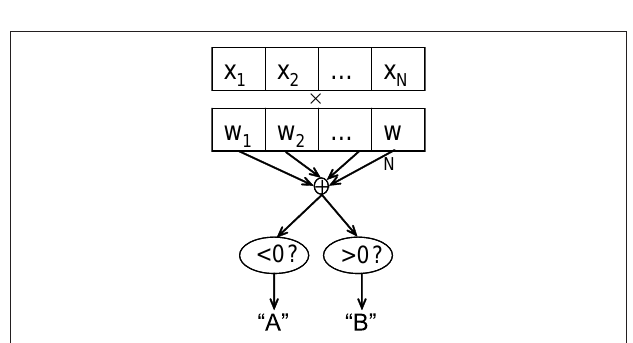
FIGURE 2 | Schematic of linear classifi cation. Each feature ( x point ( x , … , x ) is multiplied by its respective weight ( w 1 N = ∑ ⋅ ) is evaluated. The classifi er predicts that of the resulting terms (ˆ y x w i i i the data point is in “class A” if ˆ y < 0, and “class B” if ˆ y > 0.